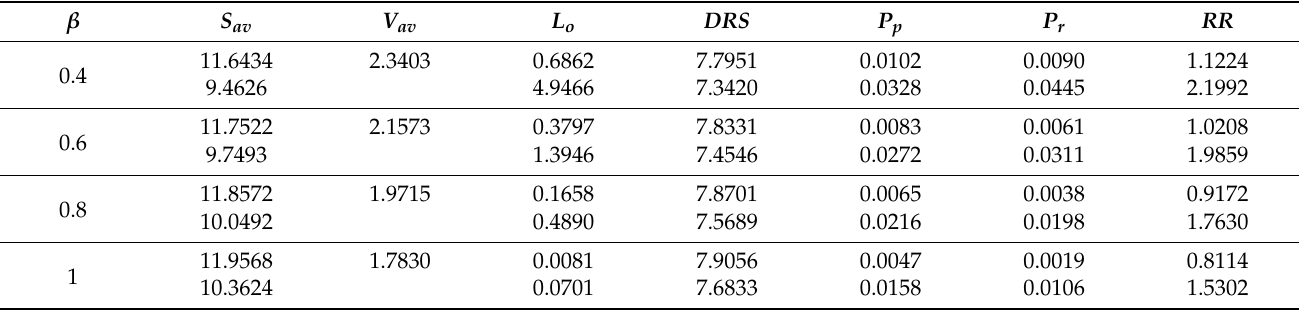
Table 6. Dependence of the performance measures on parameter β ; λ = 20, η = 15, κ = 8, ν = 10, α = 0.4, and γ =